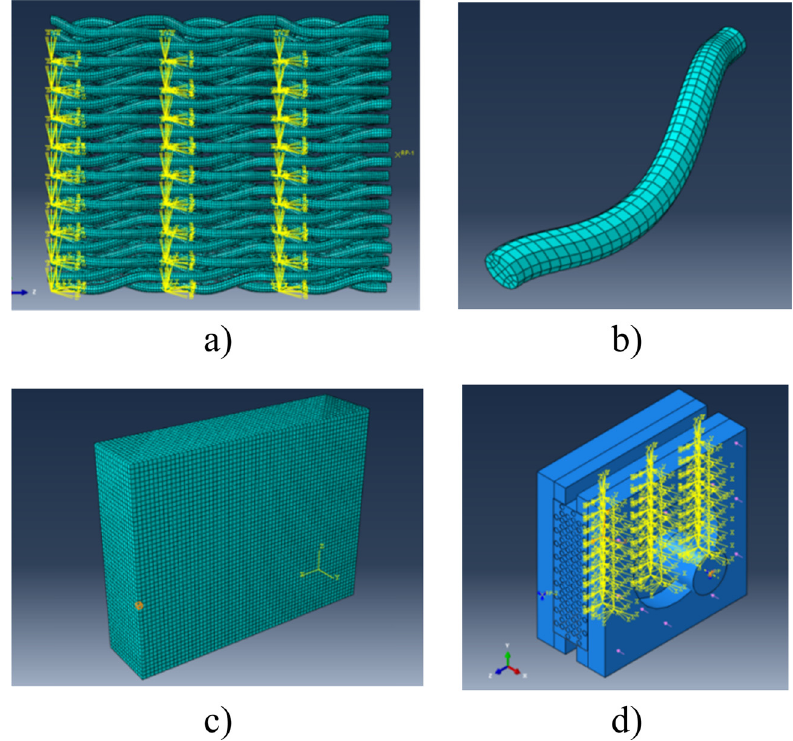
Figure 12: Model meshing and boundary conditions: ( a ) yarn overall meshing, ( b ) fi ber bundle meshing, ( c ) base meshing, and ( d ) model loads and boundary